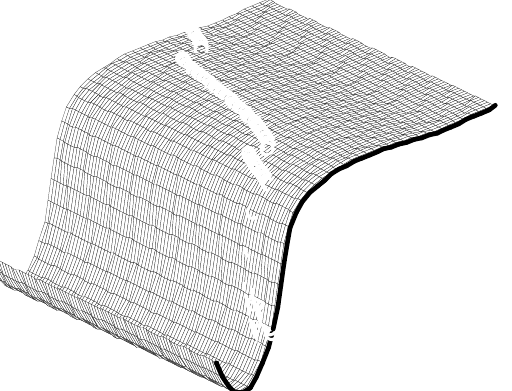
Figure 9. The position of the contact points on the surface of the wheel (rail inclination = 0).